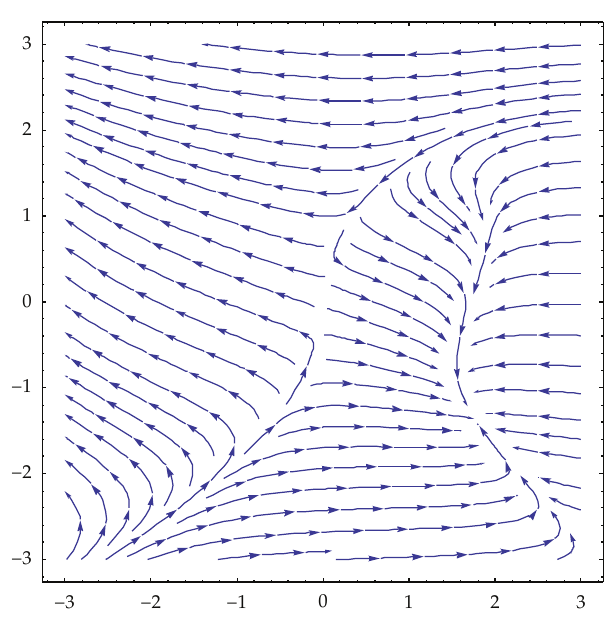
Figure 1: The graph of the vector fields (cid:3) V 1 ,V 2 (cid:4) ∇ on T (cid:7) R .